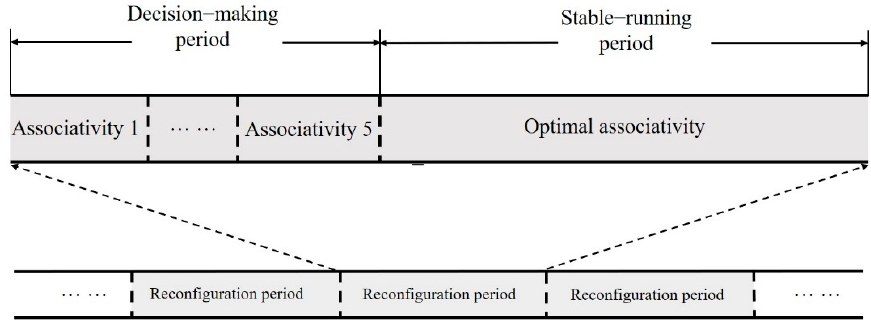
Figure 3. Optimal associativity search scheme .